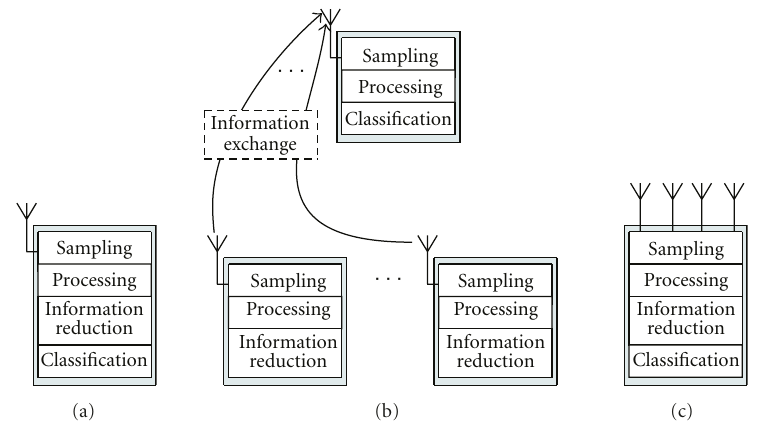
Figure 1: Considered architectures for spectrum sensing: (a) stand-alone single antenna, (b) cooperative terminals, (c) multiple antennas.